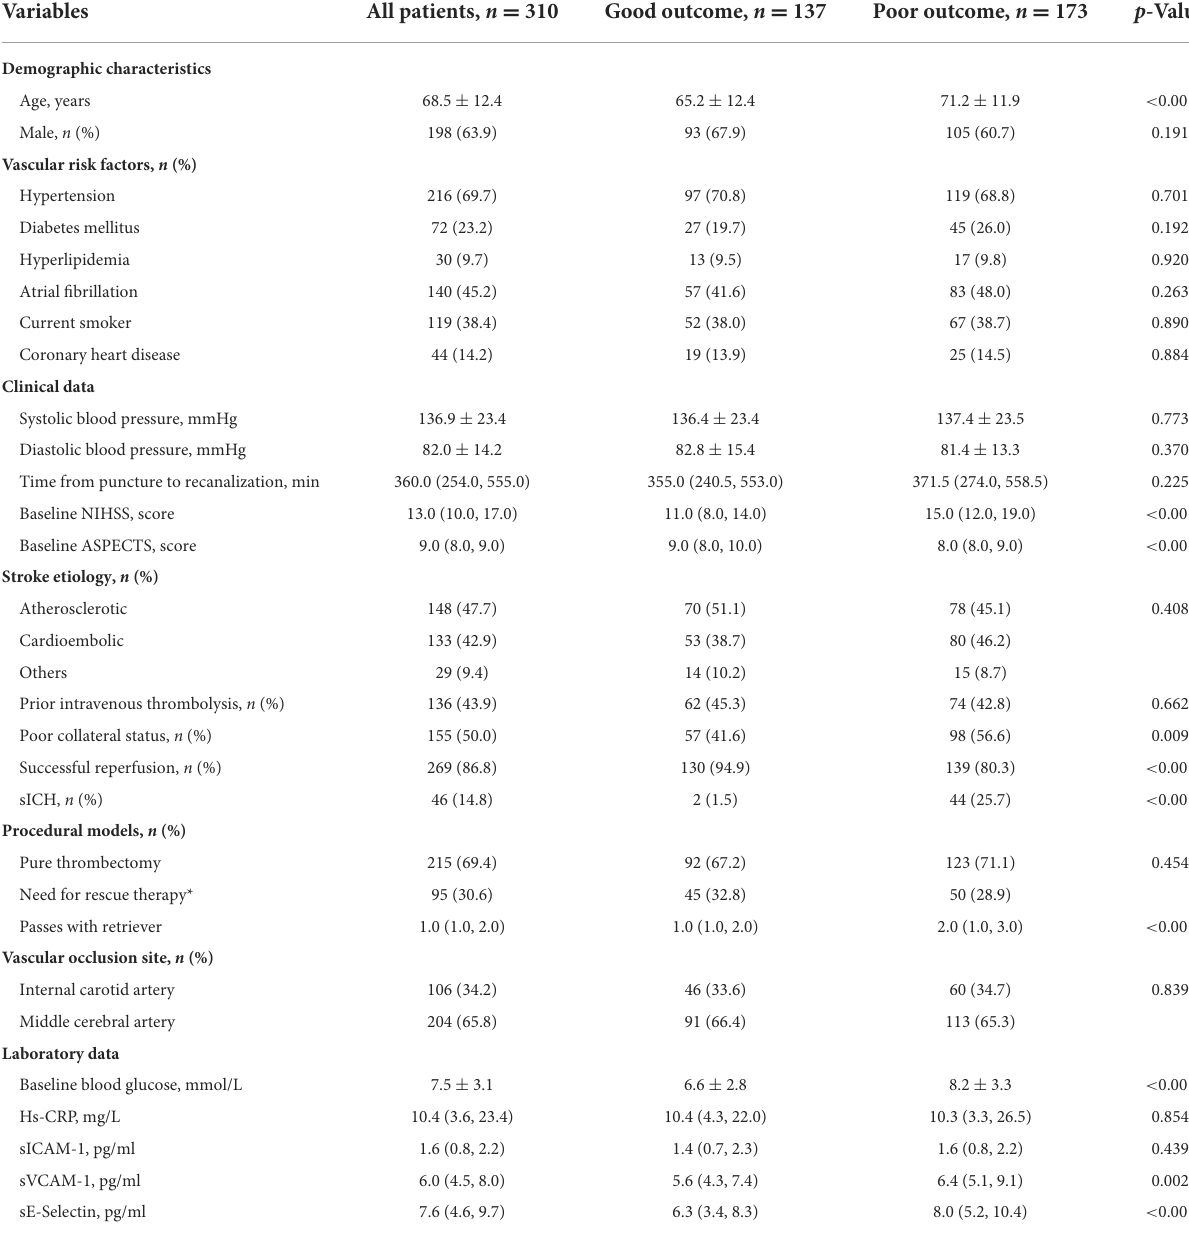
TABLE 1 Comparison of baseline data according to patients with and without a 90-day poor outcome. Variables All patients, n =